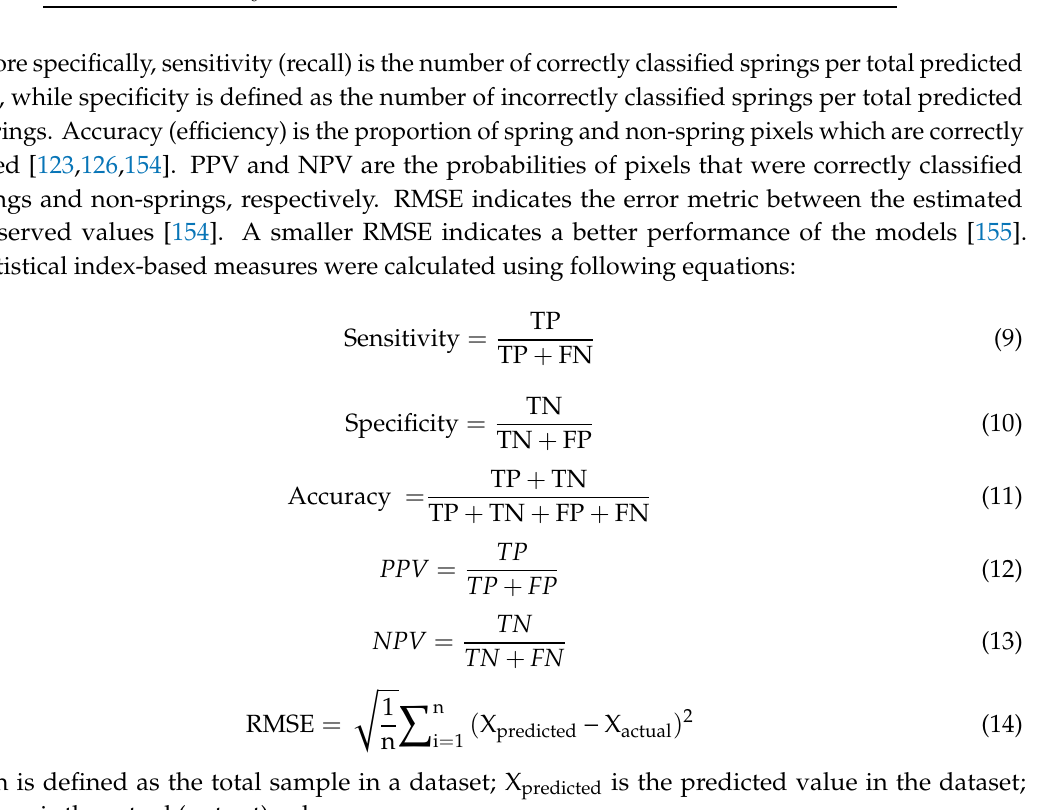
Predicted X (cid:48) (Spring) X (cid:48) (Non-Spring) Sum 0 1